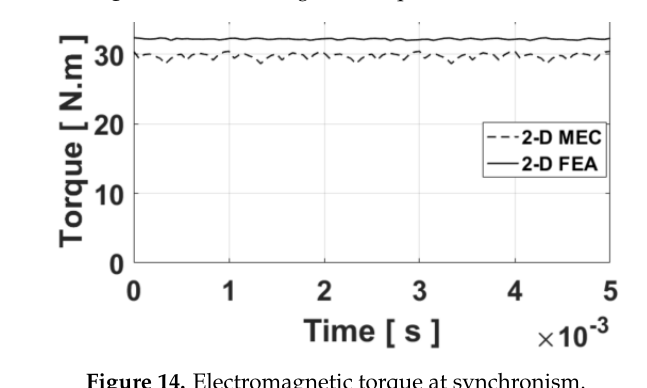
Figure 13. Electromagnetic torque at locked rotor.